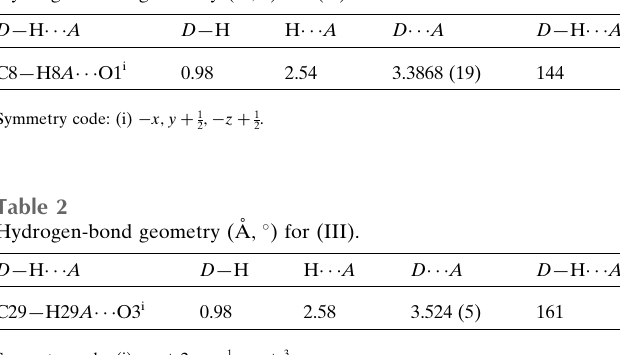
Table 1 Hydrogen-bond geometry (A˚ , (cid:2) ) for (II).